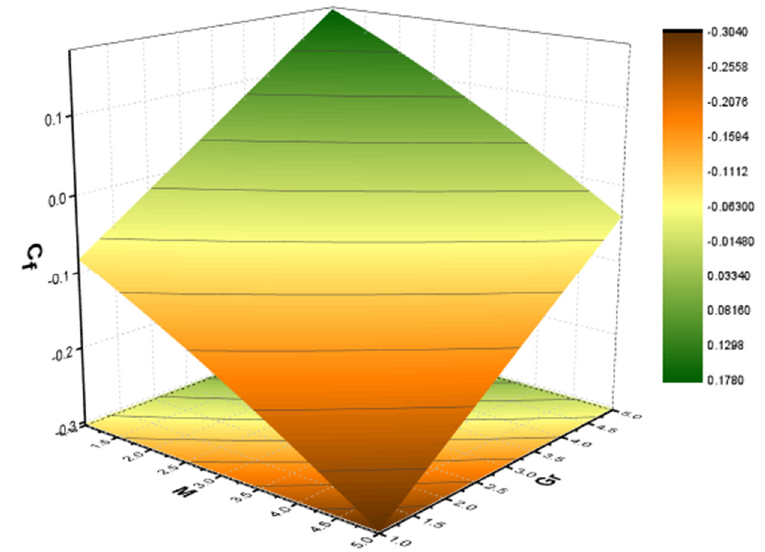
Figure 16. Impact of M and Gr on SF.